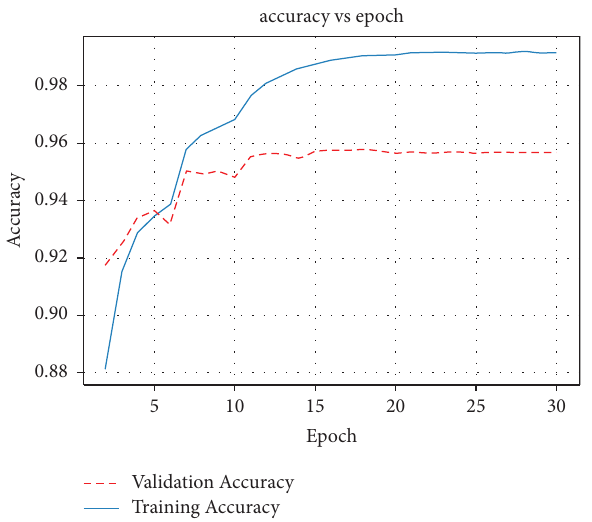
Figure 6: Observed accuracy for case 1.